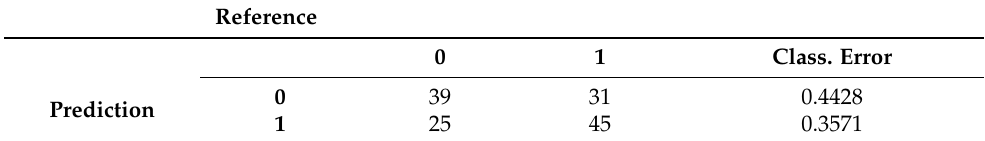
Table 8. Confusion Matrix—three features.